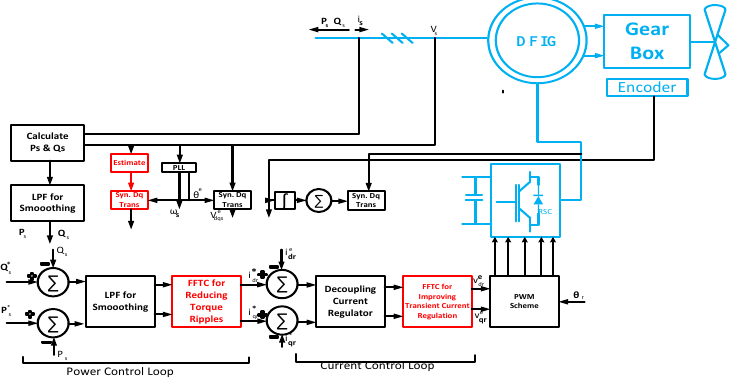
Figure 14. Feed-forward transient compensation (FFTC) structural scheme for DFIG with additional computation (in red) for FFTC implementation. RSC, rotor-side converter.